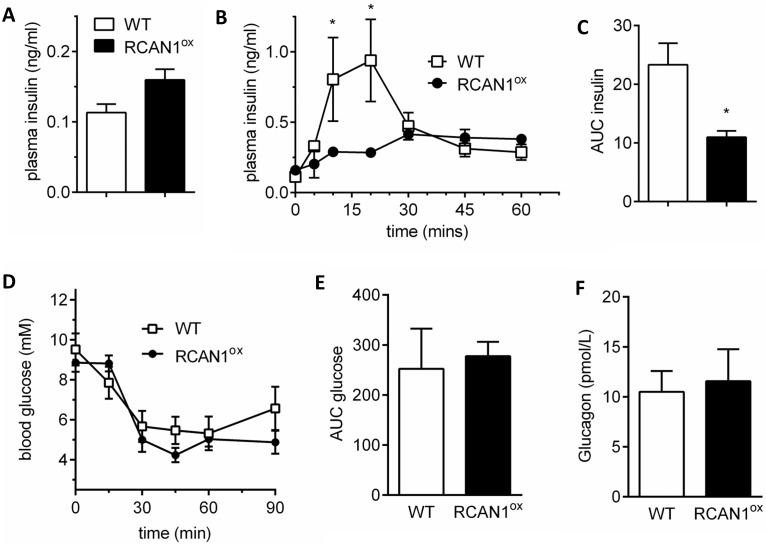
GSIS is reduced in vivo in RCAN1ox β-cells.(A) Plasma insulin is similar in WT and RCAN1ox mice (n = 3). (B) in vivo GSIS is lower in RCAN1ox mice as defined by (C) reduced area under the curve (AUC) for insulin secretion over 1 hour (n = 3). (D) Insulin sensitivity in WT (n = 4) and RCAN1ox (n = 5) mice is not different as defined by (E) AUC analysis. (F) Plasma glucagon levels are similar in WT (n = 5) and RCAN1ox (n = 4) mice. Data represents the mean ± SEM, *p<0.05.